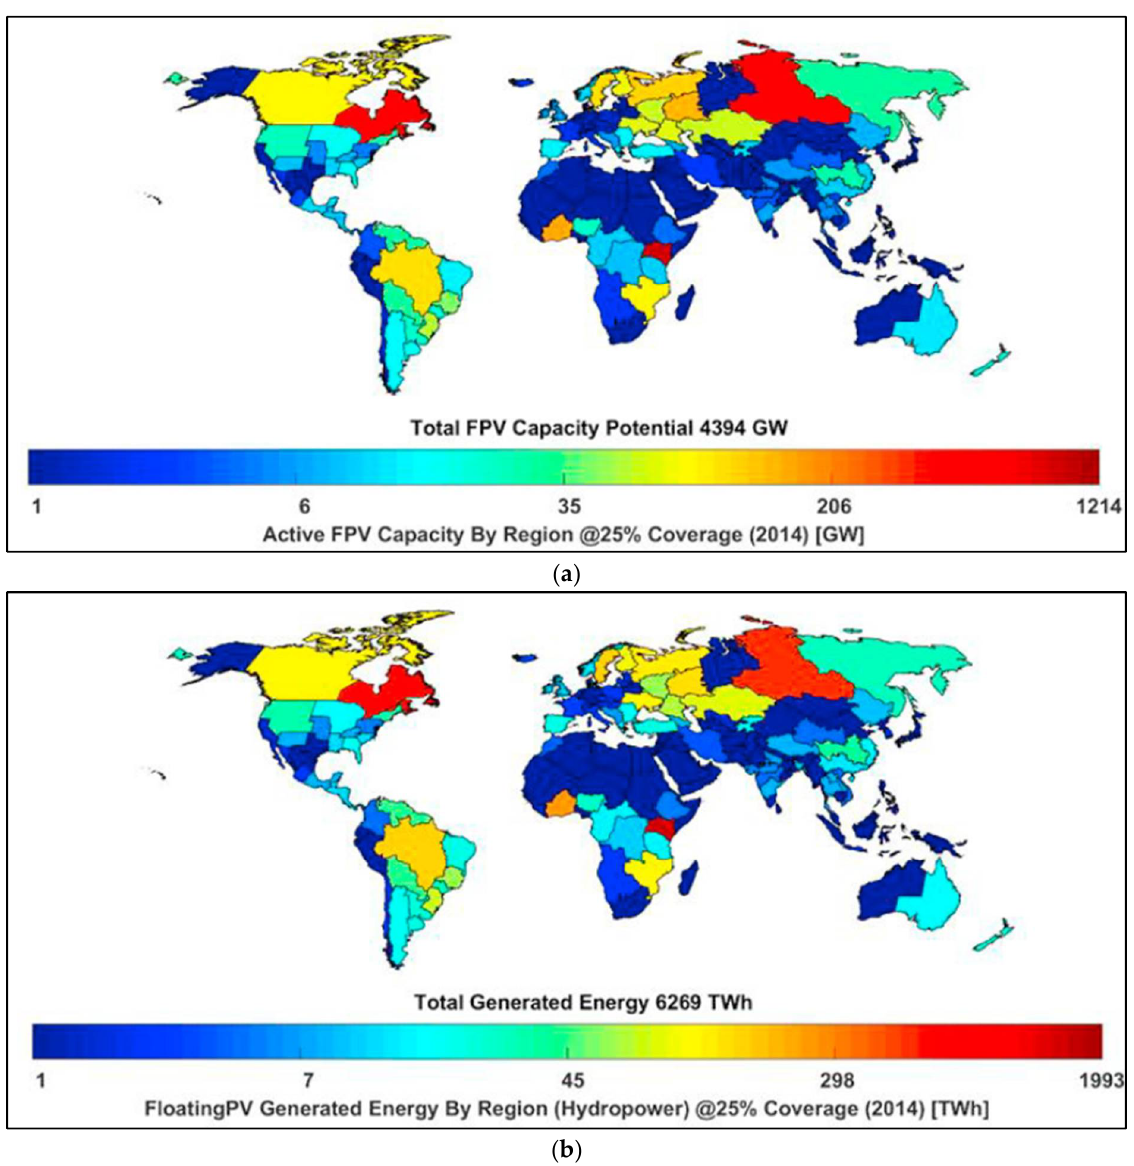
Figure 1. ( a ) Illustrating FPV capacity distribution potential in GW. ( b ) Showing electricity generation in TWh.